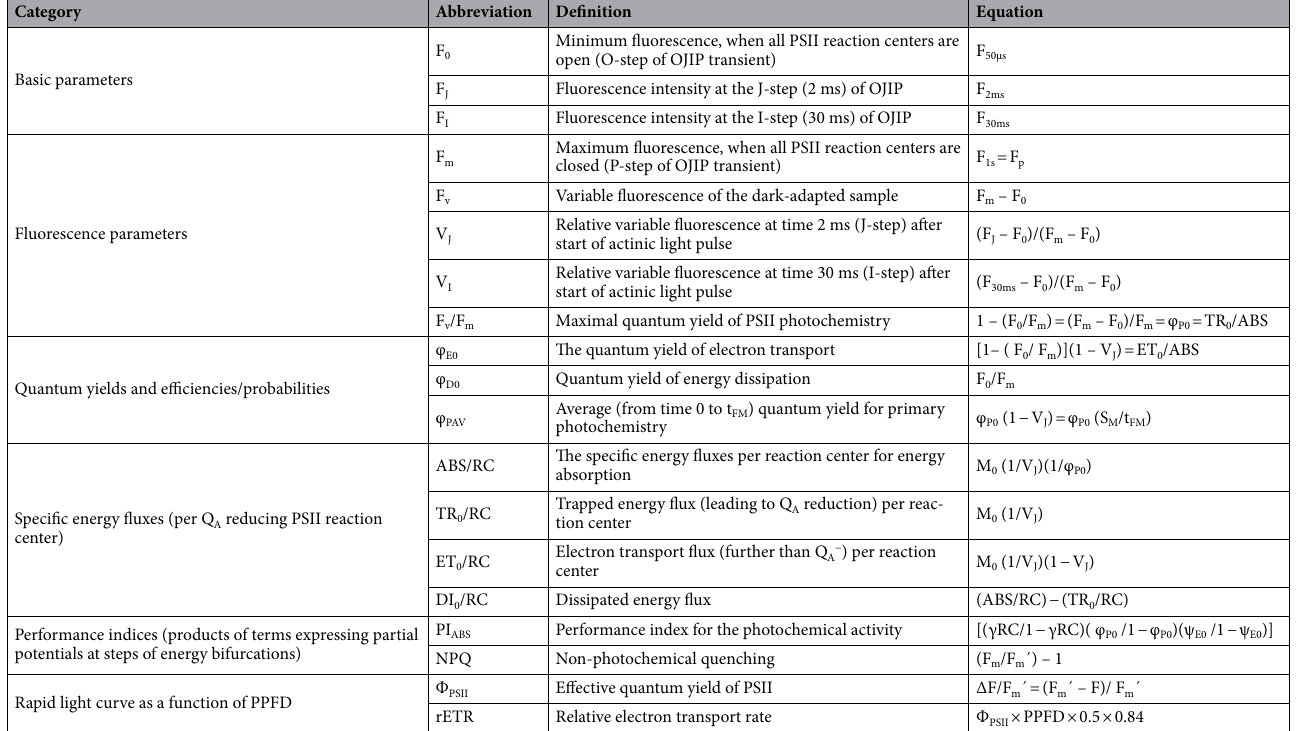
Table 3. Abbreviations, definitions and formulas of the chlorophyll fluorescence parameters assessed in the current